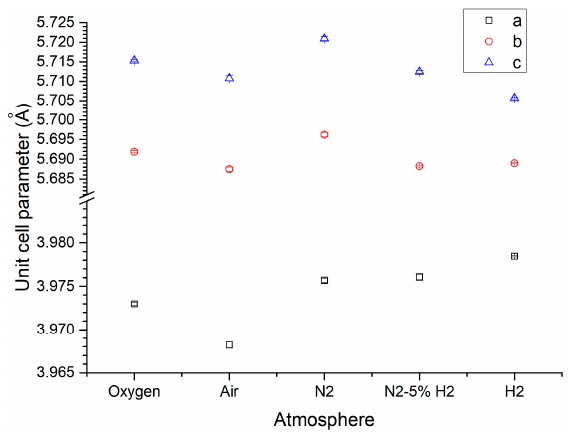
Figure 9. Unit cell parameters of KNbO 3 samples sintered at 1040 °C for 5 h in different atmospheres.